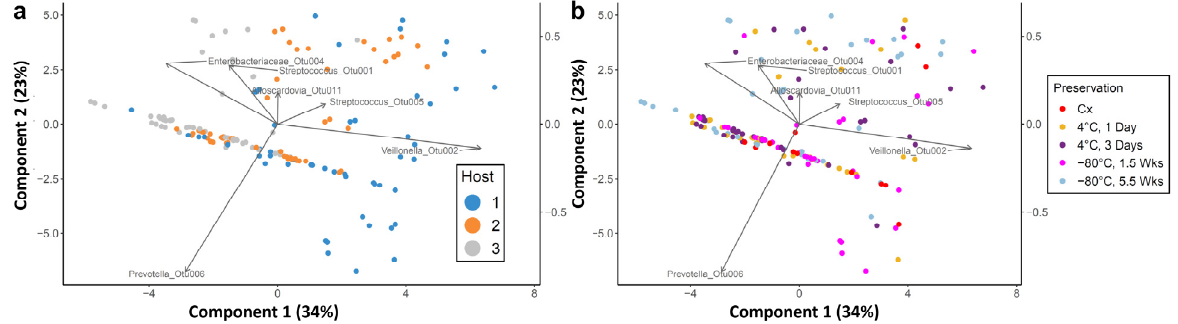
Figure 6. PCA of relative abundances after centered-log-ratio transformation, by ( a ) host or ( b ) preser- vation condition. Major patterns are similar to the non-transformed analysis, but more contributing factors were observed, including the Alloscardovia OTU and an Enterobacteriaceae